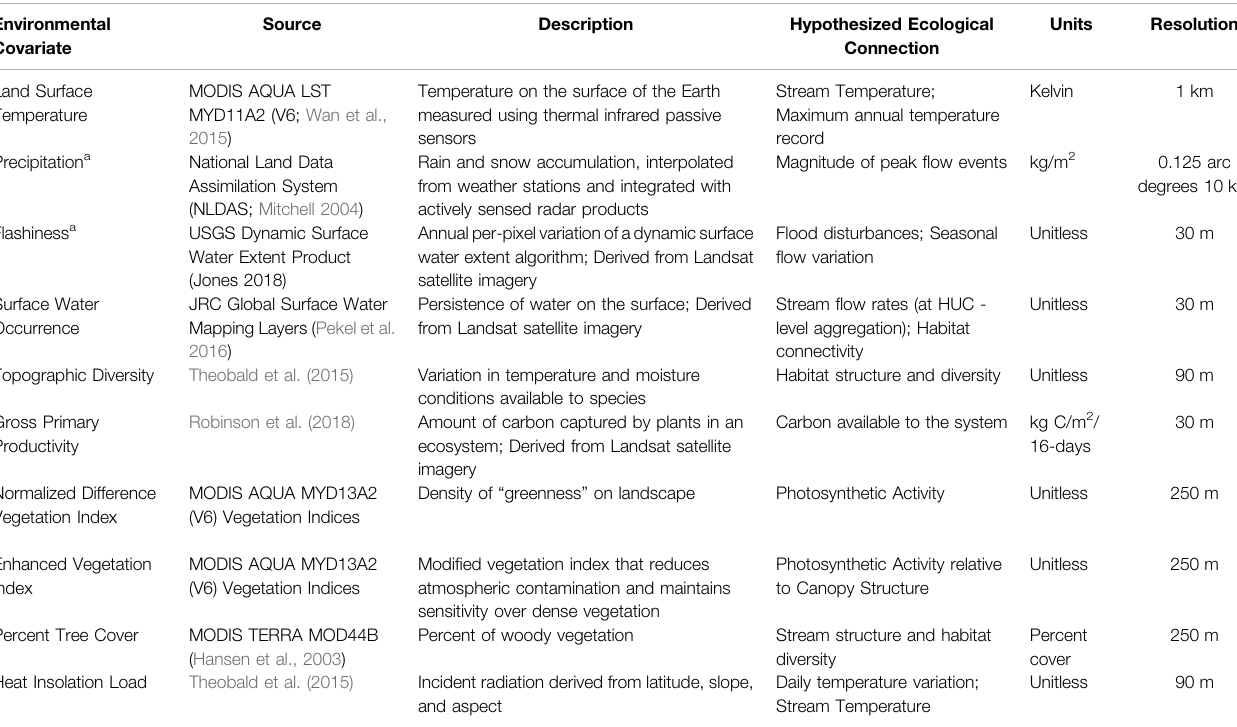
TABLE 1 | Library of hypothesized and known ecologically relevant drivers of RBT hybridization and distribution. Environmental